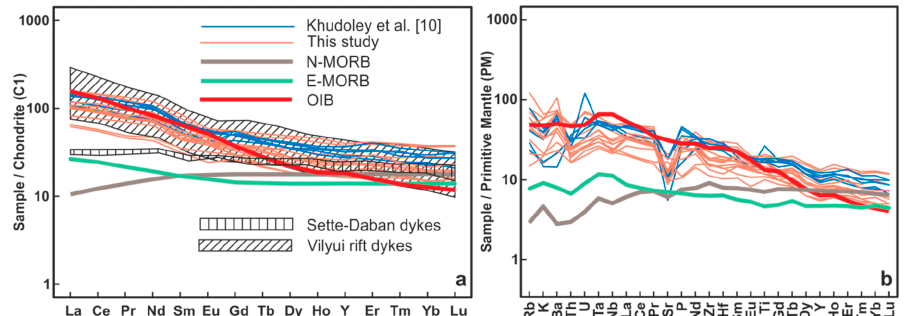
Figure 9. REE and multi-element diagrams for the Suordakh event mafic intrusions cutting the Gornostakh Anticline [10] and those cutting Cambrian units as well (this study). ( a ) Chondrite normalized REE diagrams. Fields of the Devonian Sette-Daban dykes and Vilyui rift dykes are shown for comparison after [29,45]. The Ordovician data of this study and Devonian Vilyui rift intrusions occupy the overlapping fields, whereas the Sette-Daban Devonian dykes differ from them. ( b ) Primitive mantle normalized diagrams for the Suordakh event mafic intrusions. Normalized using the Chondrite and Primitive Mantle composition of [49], respectively. N-MORB, E-MORB, and OIB compositions after [49].